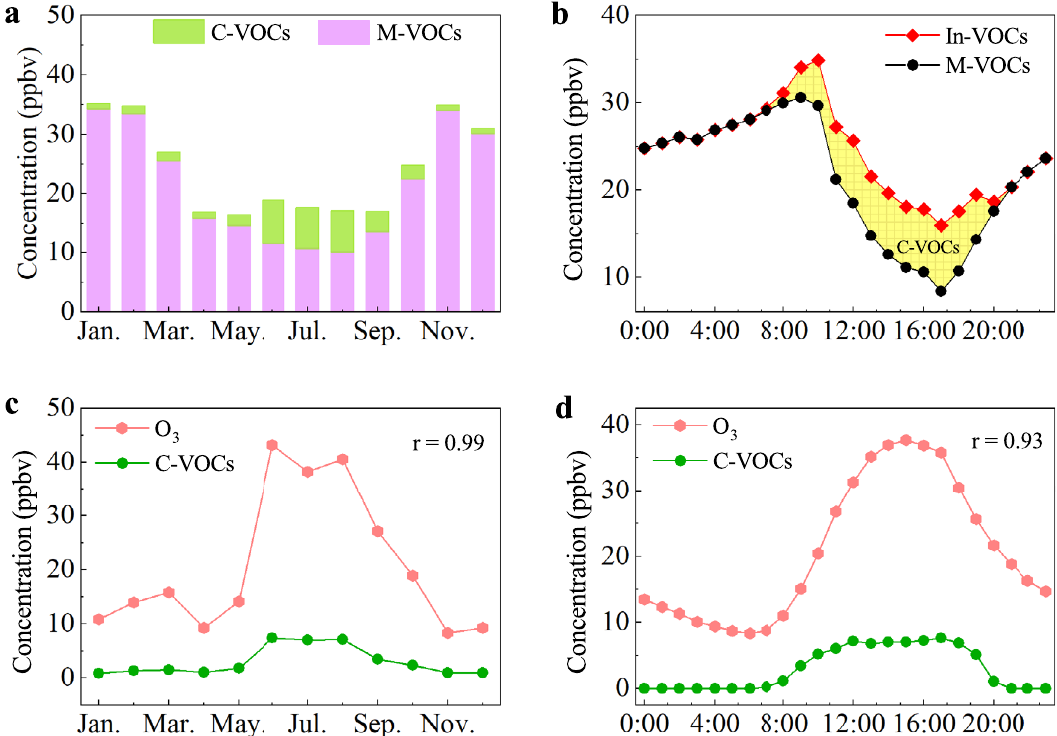
Fig. 2 Variation trends of VOCs concentrations in different reaction types and the correlation between O 3 and consumed VOCs (C-VOCs). Monthly variations of a C-VOCs and measured VOCs (M-VOCs) (average annual concentration was 21.4 ppbv), the sum of which were initial VOCs (In-VOCs) (average annual concentration was 24.3 ppbv); b average diurnal variation of In-VOCs and M-VOCs; c monthly variation of C-VOCs and O 3 ; and d diurnal trends of C-VOCs and O 3 . a , b show that C-VOCs are consumed VOCs and M-VOCs are the survivable VOCs after consumption. In c , d , the high time-series consistency between C-VOCs and O 3 con fi rms the key role of C-VOCs in O 3